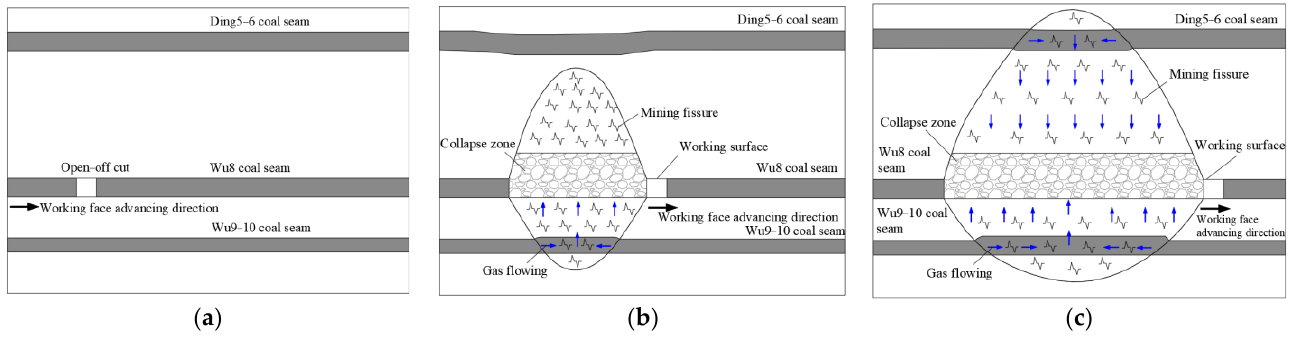
Figure 9. Gas flow characteristics of adjacent coal seams during advancing of the working face. ( a ) Unmined coal seams. ( b ) Stage I. ( c ) Stage II.